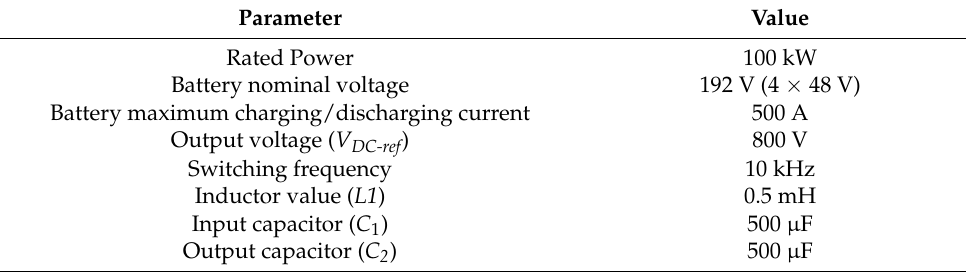
Table 3. Design parameters of the bidirectional converter